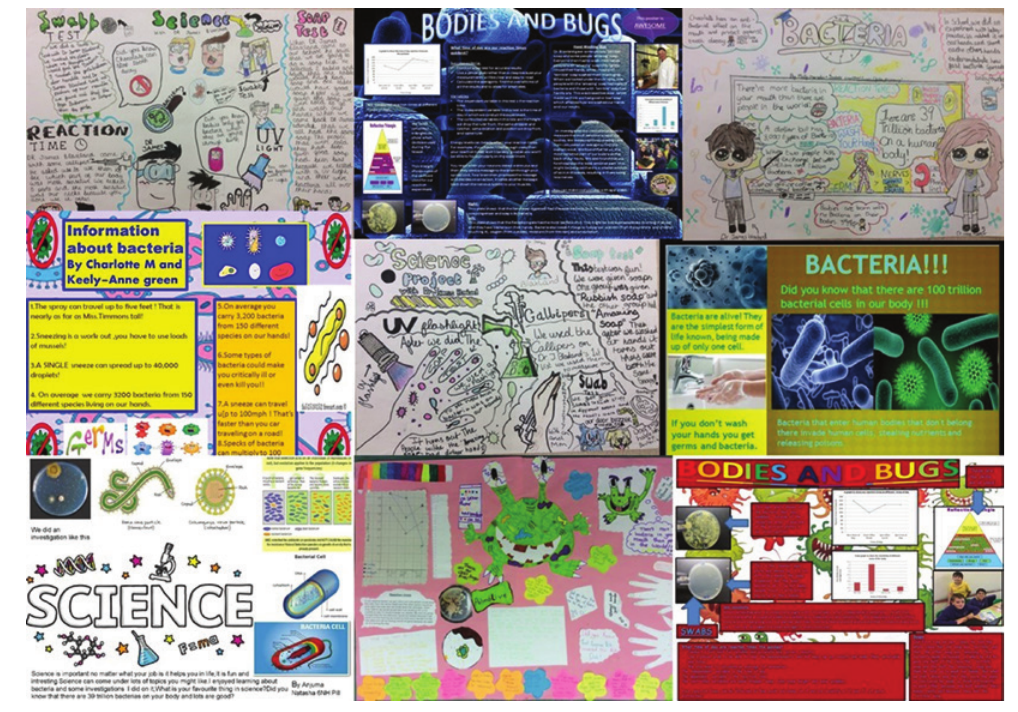
Figure 7: A representative selection of posters produced by pupils (source: